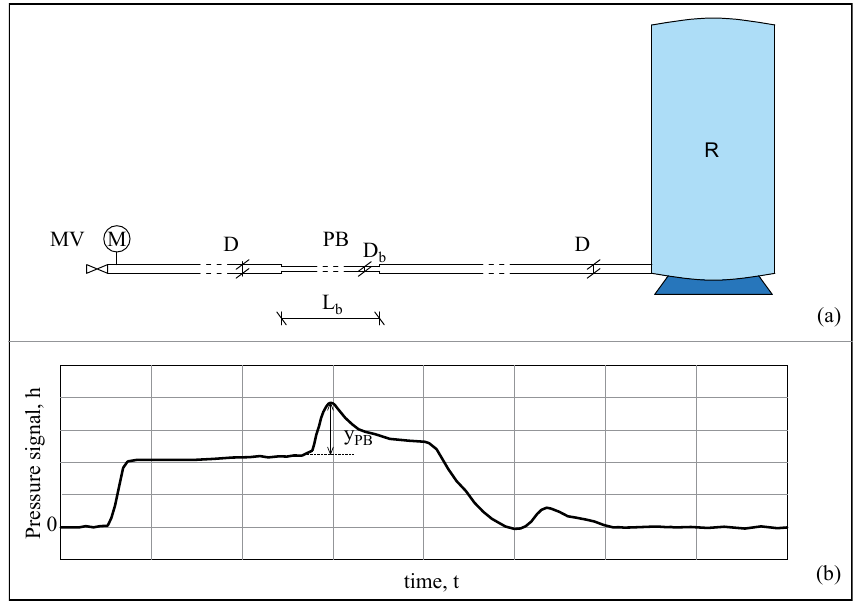
Figure 5. Small-bore pipe simulating an extended partial blockage: ( a ) sketch of the experimental setup at the Water Engineering Laboratory (WEL) of the University of Perugia, Italy (MV = maneuver valve, M = measurement section, PB = (extended) partial blockage, R = reservoir), ( b ) pressure signal during the transient generated by the complete closure of MV (modified from